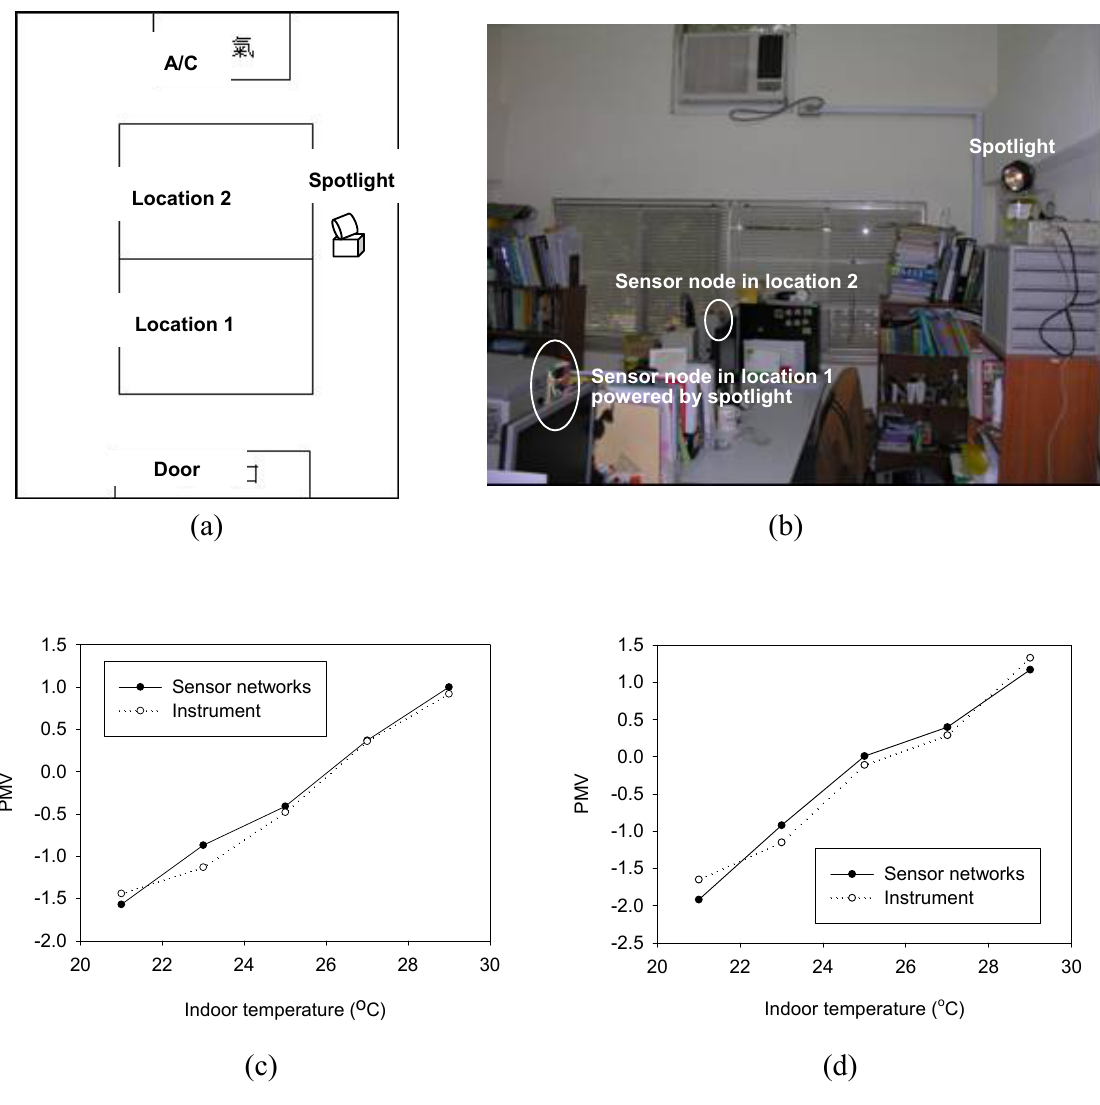
Figure 5. PMV indices in the simulated thermal environment. The schematic view of the space arrangements is shown in (a). The photograph of the light powered sensor networks assembled in the thermal environment is shown in (b). Panel (c) and (d) illustrate the PMV indices obtained by the commercial instrument and the light powered sensor networks at the location 1 and 2